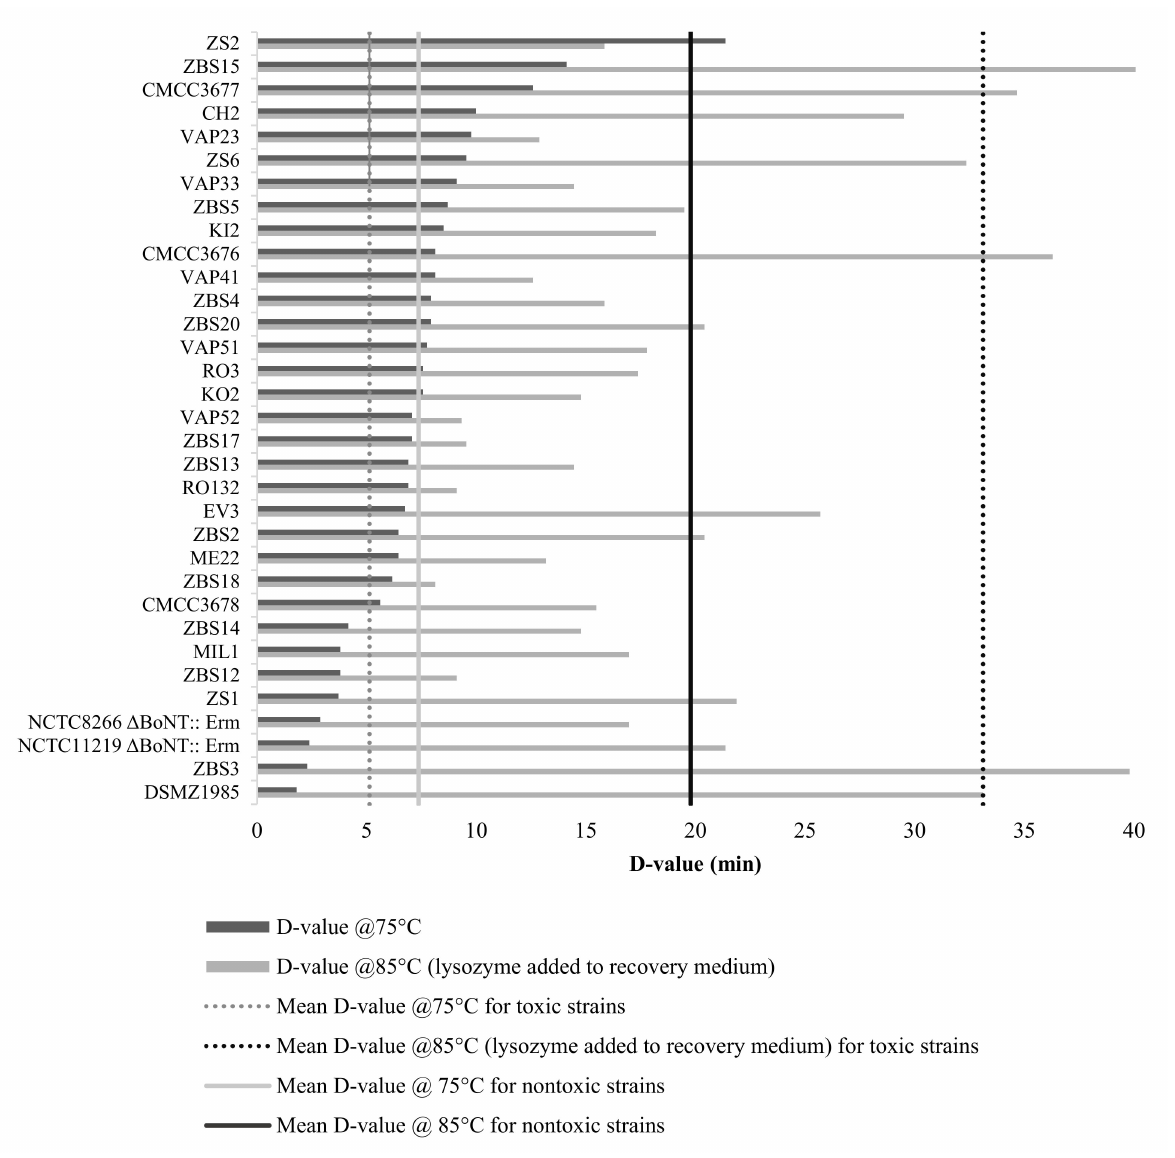
Figure 3. D-values at 75 ◦ C and 85 ◦ C for all nontoxic isolates, NCTC8266 ∆ bont::ermB and NCTC11219 ∆ bont::ermB. The recovery medium for spores treated at 85 ◦ C was supplemented with 10 µ g/mL lysozyme. Vertical dashed lines represent mean D-values for strains analyzed in this work at 75 ◦ C (light grey) and at 85 ◦ C (black). Vertical dotted lines represent mean D-values for toxic group II strains from a published meta-analysis at 75 ◦ C (light grey) and at 85 ◦ C with lysozyme (black). Reprinted/adapted with permission from Ref. [49]. Copyright 2016, copyright Wachnicka et al. D-values were calculated from the log-linear part of the reduction